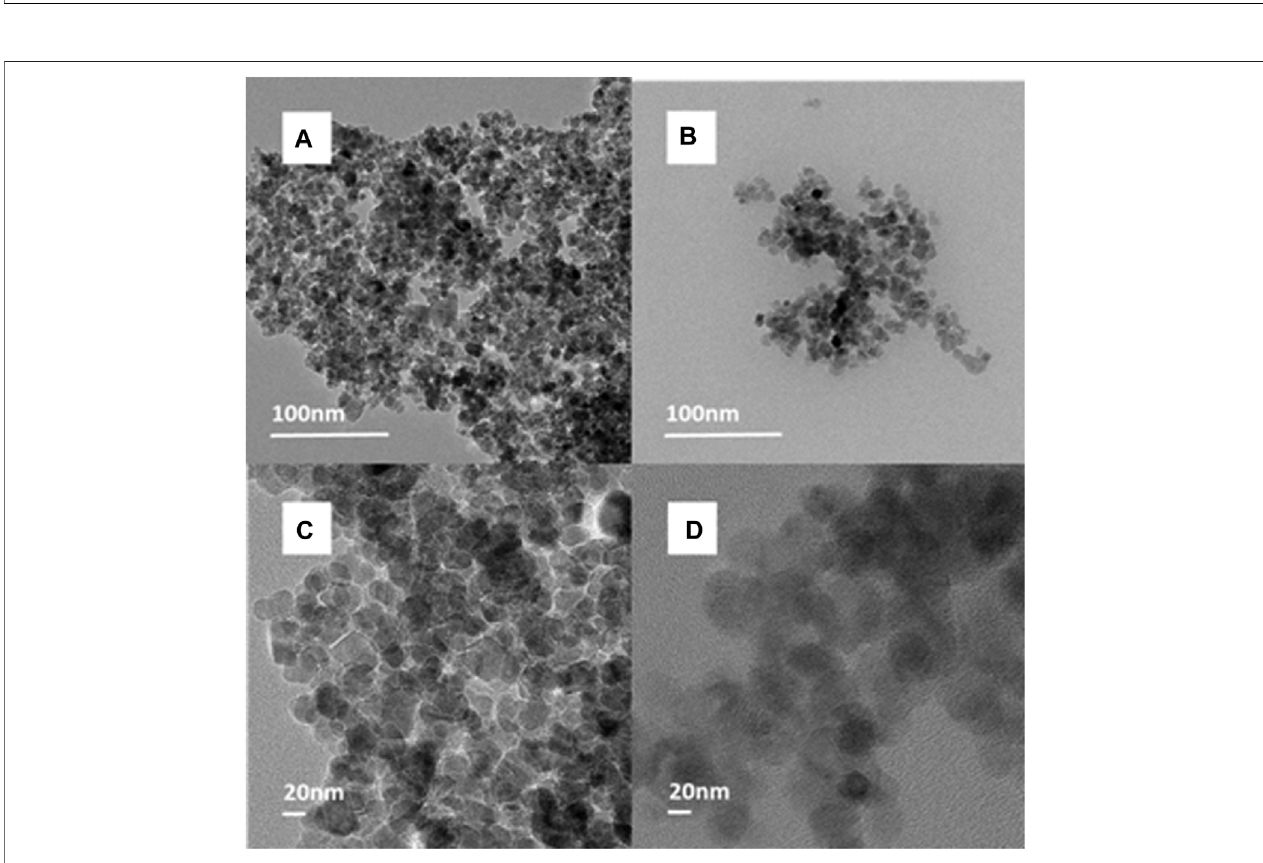
FIGURE 4 | TEM images of (A,C) Fe 3 O 4 -CS and (B,D) Fe 3 O 4 -CS-DAC.